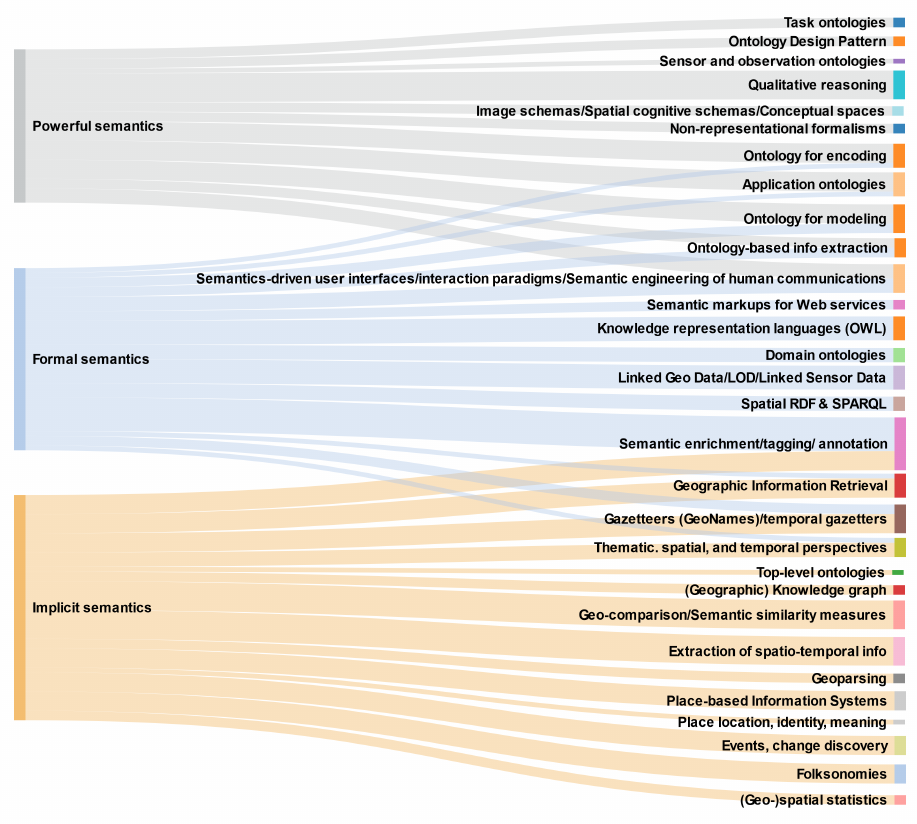
Figure 5. Comparison between the grouping of keywords in Figure 2 (on the right-hand side) and the grouping induced by the three forms of geosemantics (via the case studies) makes it apparent their greater distinguishing